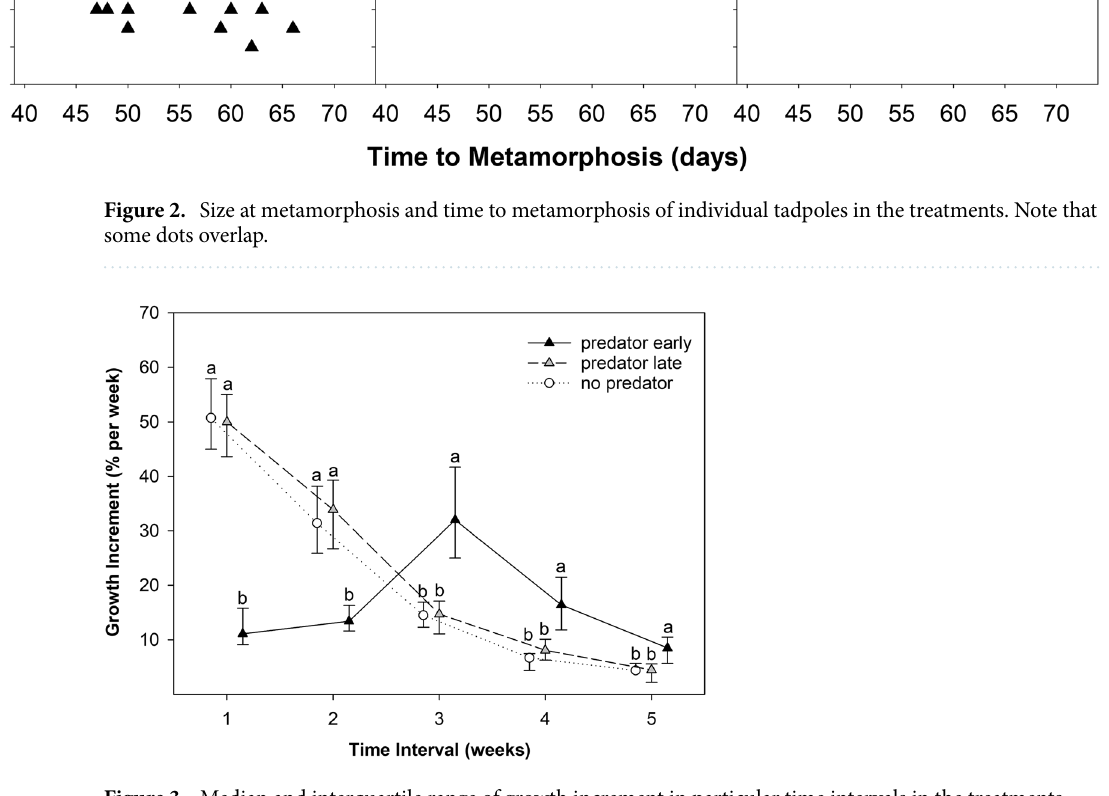
Figure 3. Median and interquartile range of growth increment in particular time intervals in the treatments. Different letters indicate a significant